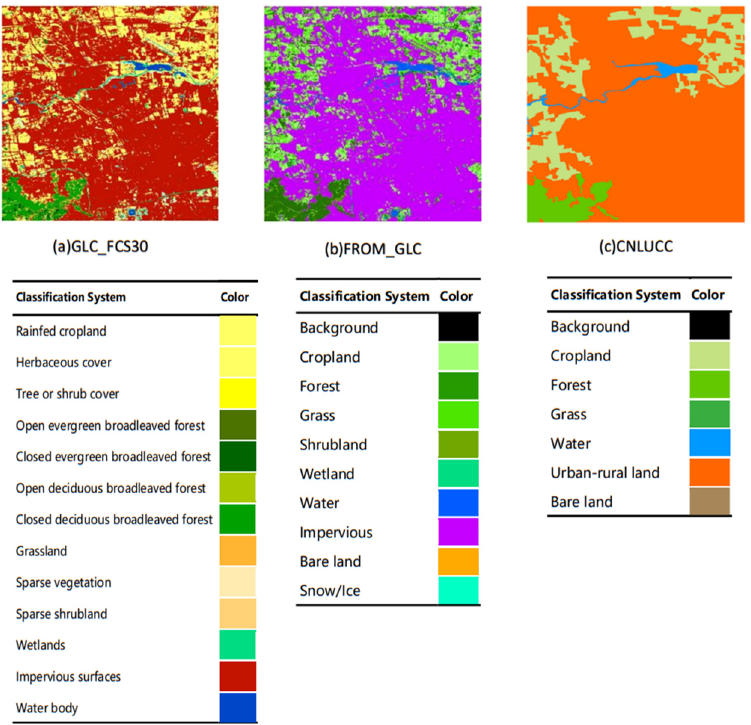
Figure 6. Detail of GLC_FCS30, FROM_GLC and CNLUCC datasets.